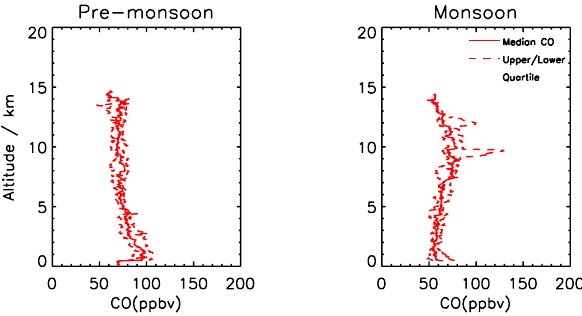
Fig. 1. Median CO vertical profile measured by the Egrett during (a) the pre-monsoon (left) and (b) monsoon (right) seasons. The dashed lines are the lower and upper quartiles of the